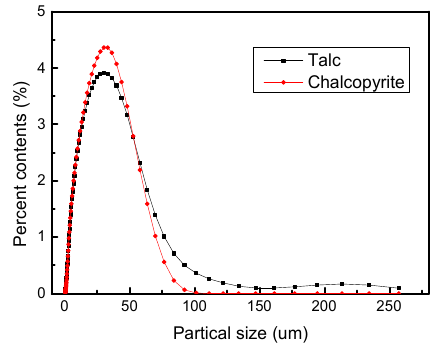
Figure 2. The particle size distribution curves of talc and chalcopyrite samples.